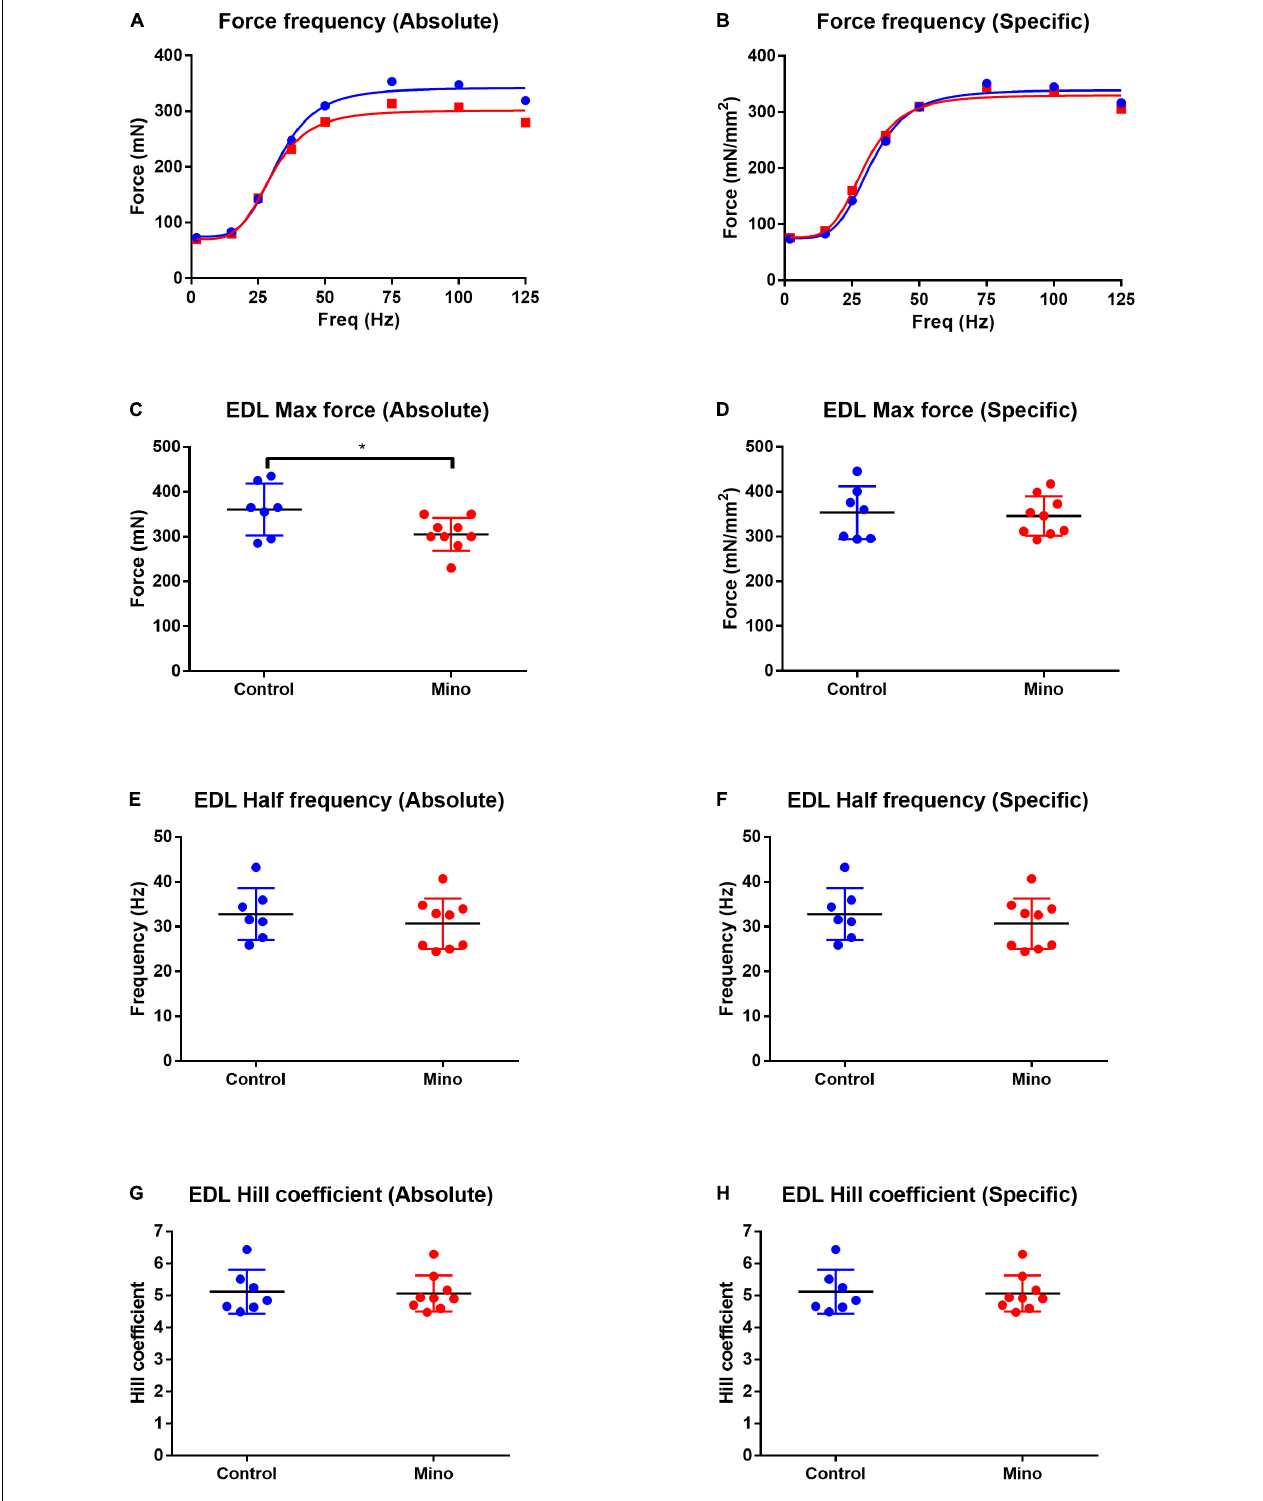
FIGURE 1 | Force frequency characteristics of the fast-twitch EDL muscle expressed in absolute and specific (relative to muscle CSA) units from control (blue) and minocycline (Mino; red) groups. (A,B) Force frequency curve from the EDL in absolute (A) and specific (B) units, which were not different with minocycline treatment. (C,D) Lower EDL absolute maximal force in minocycline treated-mice (C) , but not when expressed relative to muscle CSA (D) . (E,F) EDL half frequency was not different with minocycline treatment in either absolute (E) or specific (F) units. (G,H) EDL Hill coefficient was not different with minocycline treatment in either absolute (G) or specific (H) units. n = 7 for Control, and n = 9 for Mino for all measures. * p < 0.05 via unpaired t -test. Values are mean ± SD.